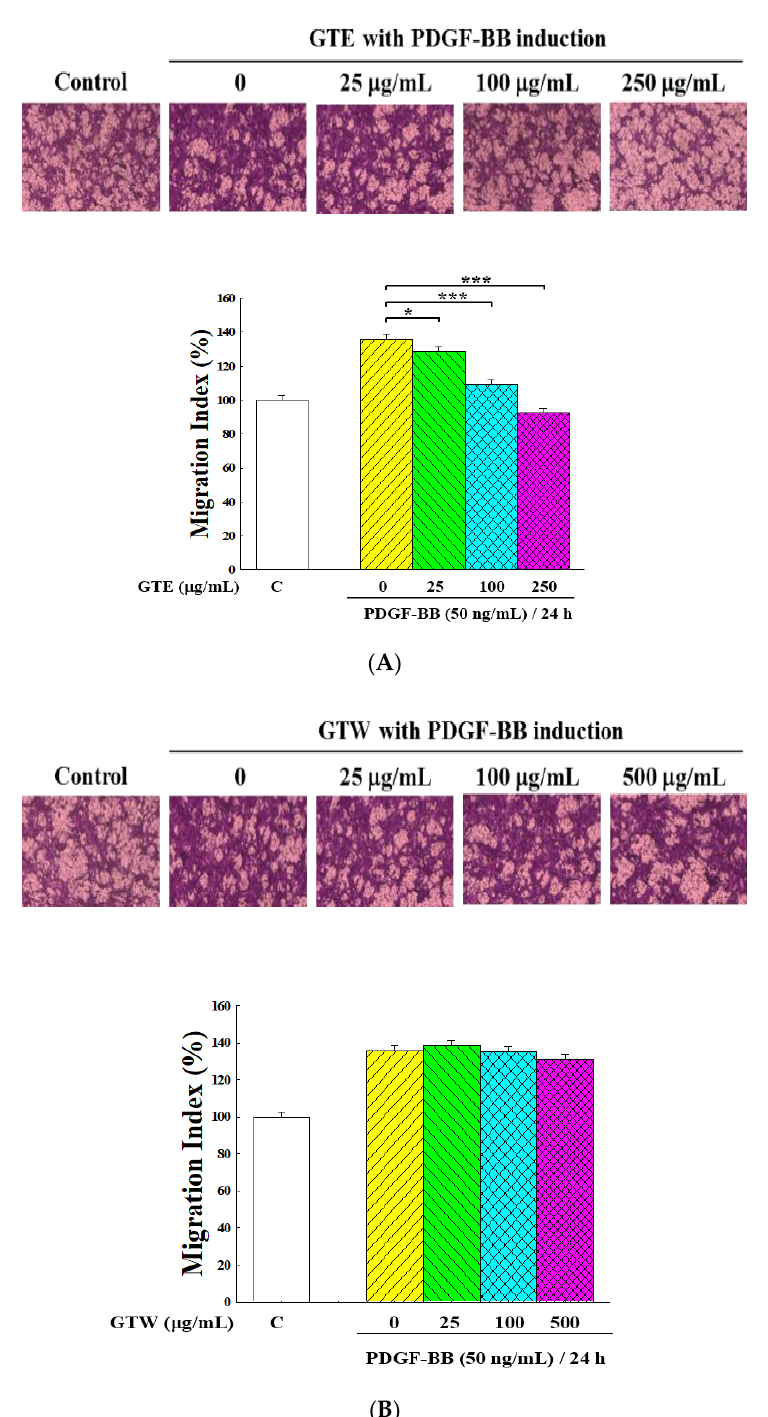
Figure 3. Inhibitory effects of GTE and GTW on the cell migration of PDGF-BB-stimulated VSMCs by a transwell assay. The migration assay was performed using a Boyden chamber. The PDGF-BB-stimulated VSMCs were treated with various concentrations of GTE ( A ) and GTW ( B ) for 24 h. Group C was the VSMC growth without PDGF-BB stimulation and GT extract treatment. Crystal violet was used to stain the cells that penetrated through the polycarbonate membrane to the surface under the filter, photographed with a phase-contrast microscope, and the number of penetrated cells were counted. Data were obtained from five independent experiments. Significant di ff erences compared with the vehicle (group 0) are denoted as * p < 0.05 and *** p <